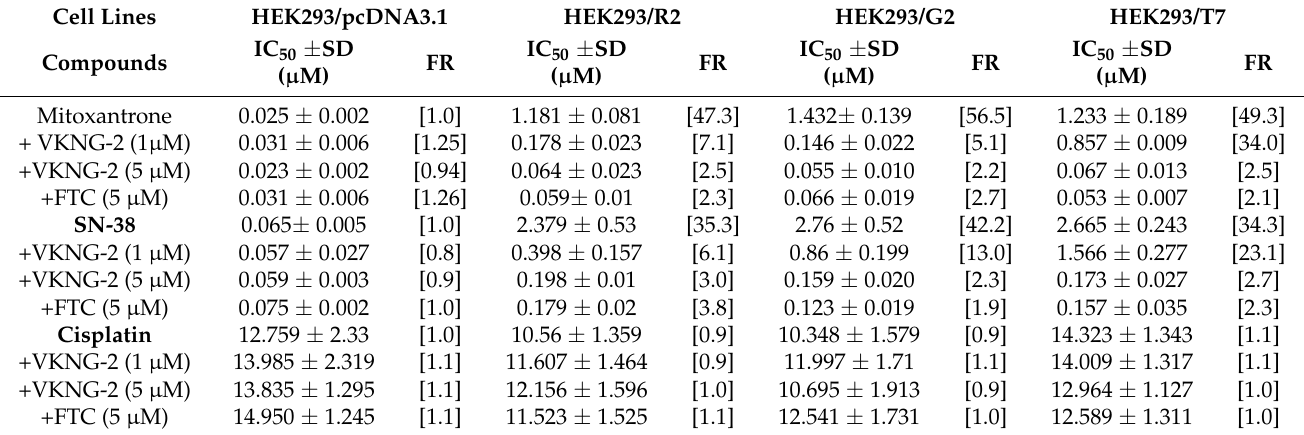
Table 3. The effect of VKNG-2 on reversal of ABCG2 mediated MDR in the transfected cell